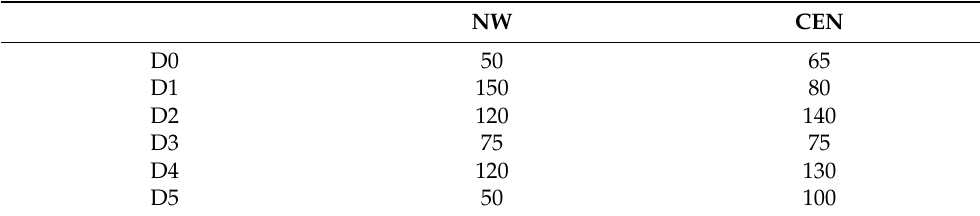
Table 14. Indicator semi-variogram ranges in meters for the various rock domains in NW and